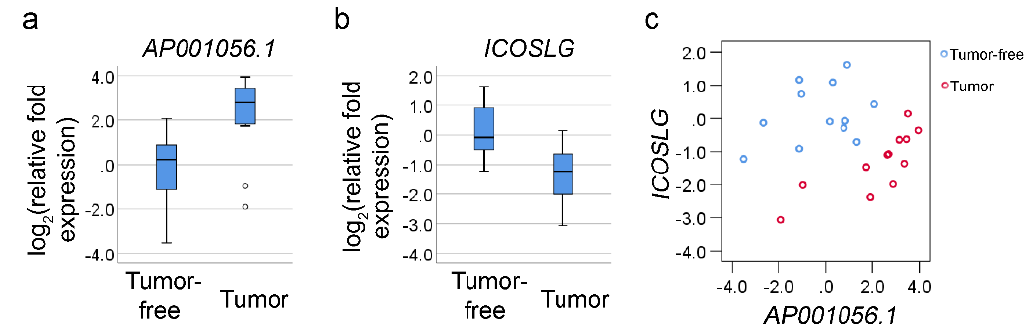
Figure 3. Quantification of AP001056.1 and ICOSLG levels by RT-qPCR. ( a , b ) Boxplots showing log transformed relative fold levels of AP001056.1 and ICOSLG in matched tumor-free and tumor samples from 12 patients with oral tongue SCC. Small circles indicate outliers. ( c ) Scatterplot showing correlation between AP001056.1 and ICOSLG mRNA in tumor-free and tumor samples.